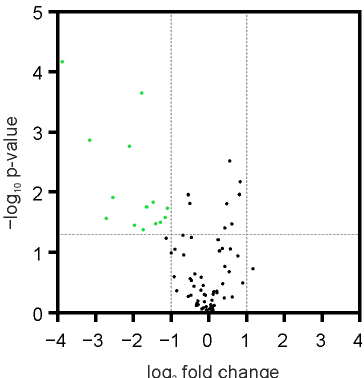
Figure 5. The effect of BET inhibitor JQ1 on the expression of phagocytosis-related genes in phagocyting microglia. BV2 cells were incubated in the absence or presence of 50 nM JQ1 for 24 h, and then FMS were added for 2 h and mRNA levels were determined using a gene expression array. The genes, the expression of which was significantly (FC > 2, p < 0.05) altered by JQ1, were marked on the volcano plot with green color. n = 4. Statistical analysis was performed by using the Student t -test.